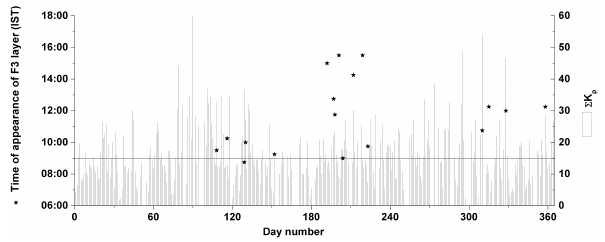
Fig. 4a. Variation in the time of appearance of the F3 along with the daily average K p (6K p ) during 2001. F3 layer was observed for 17 days.